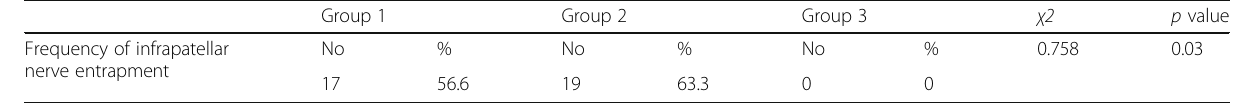
Table 6 Frequency of infrapatellar nerve entrapment among patients of the three studied groups Group 1 Group 2 Frequency of infrapatellar nerve entrapment